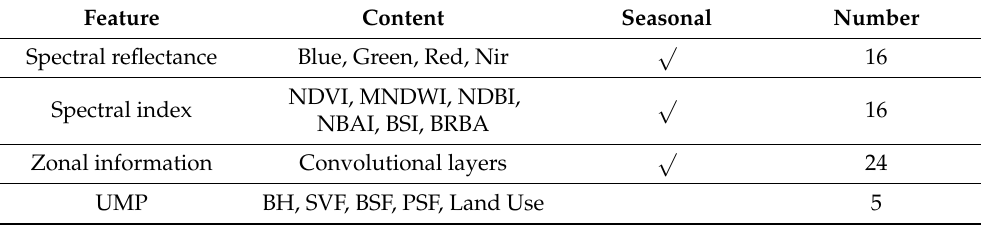
Table 2. Overview of features in the data